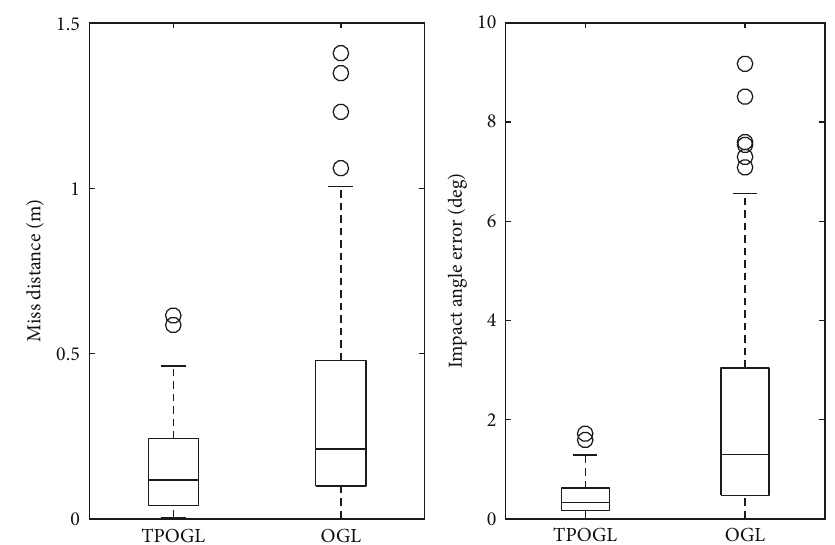
Figure 8: Distributions of errors against stationary targets.